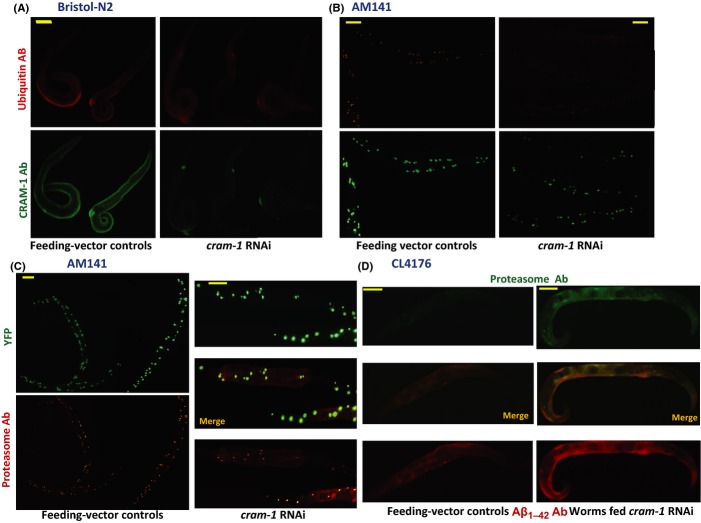
Immunofluorescence detection of cram-1 RNAi effects on wild-type worms and worms expressing Q40::YFP or Aβ1–42 in muscle. (A–D) Adult Caenorhabditis elegans; scale bars are 0.1 mm. (A) N2 (wild-type) worms were fed cram-1 RNAi or FV, from hatch. Adults (4 dPH) were immunostained with primary antibody to ubiquitin or CRAM-1. (B, C) AM141 (5 day) worms were imaged by YFP fluorescence and fluor-tagged antibody to ubiquitin (B) or proteasomes (C). (D) CL4176 worms, induced at 2 dPH, were imaged 40 h later with antibodies to Aβ1–42 and proteasomes. Channel crossover was < 5%; fluorescence was reduced > 85% in controls w/o primary antibody.